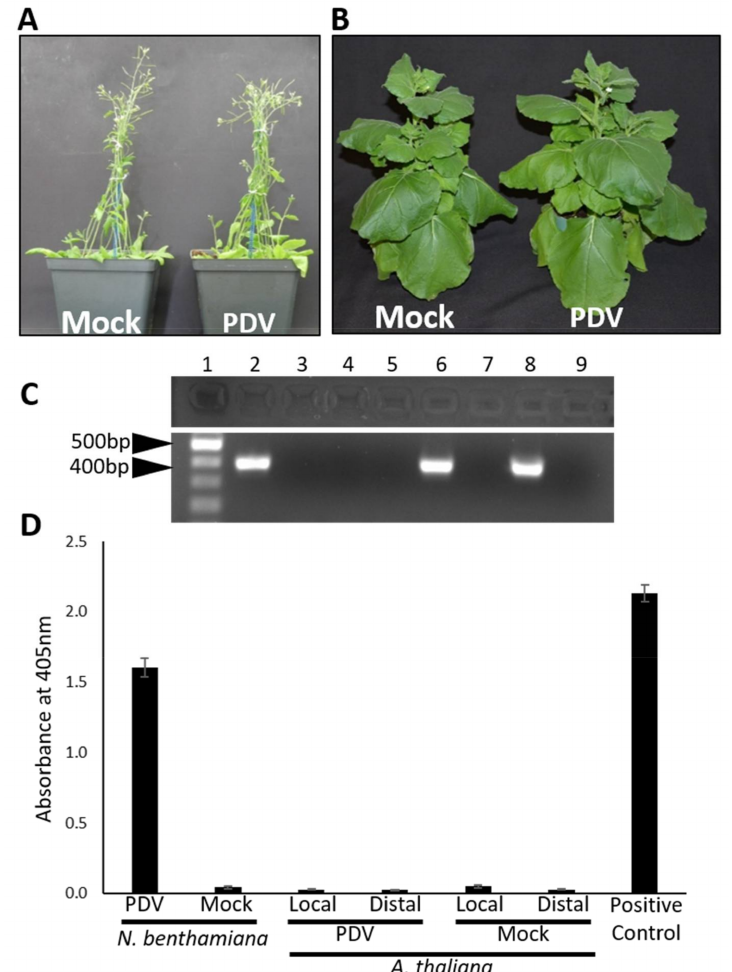
Figure 4. PDV does not infect Arabidopsis and infects N. benthamiana latently. The cDNA clone of PDV was used to infiltrate commonly used experimental host plants. ( A ) Arabidopsis seedlings agroinfiltrated with the full-length cDNA clone of PDV (right) did not develop any visible symptoms and could not be differentiated from mock inoculated plants (left) at 21 dpa. ( B ) N. benthamiana plants agroinfiltrated with the full-length cDNA clone of PDV did not develop any visible symptoms and could not be differentiated from mock treated plants at 21 dpa. ( C ) RT-PCR was used to detect PDV in both plants. The coding sequence of the CP was amplified as 900 bp in size. Lane 1: 1000 bp DNA ladder; 2: locally infiltrated Arabidopsis rosette leaf at 7 dpa; 3: distal leaf of PDV infiltrated Arabidopsis at 21 dpa; 4: mock infiltrated rosette leaf of Arabidopsis; 5 distal leaf of mock infiltrated plant; 6: upper leaf of PDV infiltrated N. benthamiana plant at 21 dpa; 7: upper leaf of mock infiltrated N. benthamiana plant at 21 dpa; 8: A sample of foliar tissue known to be infected with PDV served as a positive control; 9: water was used as a negative control to test PCR reactions. ( D ) Relative levels of PDV accumulation in locally infiltrated leaves of Arabidopsis at 7 dpa and distal leaf tissues of Arabidopsis and N. benthamiana at 21 dpa were determined by DAS-ELISA. Error bars represent the standard error of the means. Arabidopsis plants were